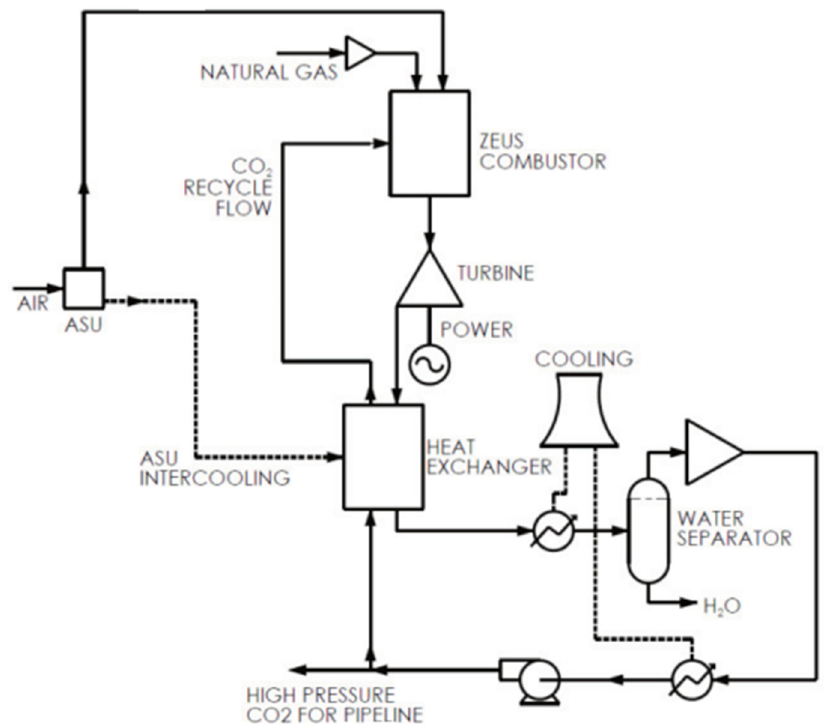
Figure 12. Schematic of the Allam power cycle operating on natural gas as fuel [107].